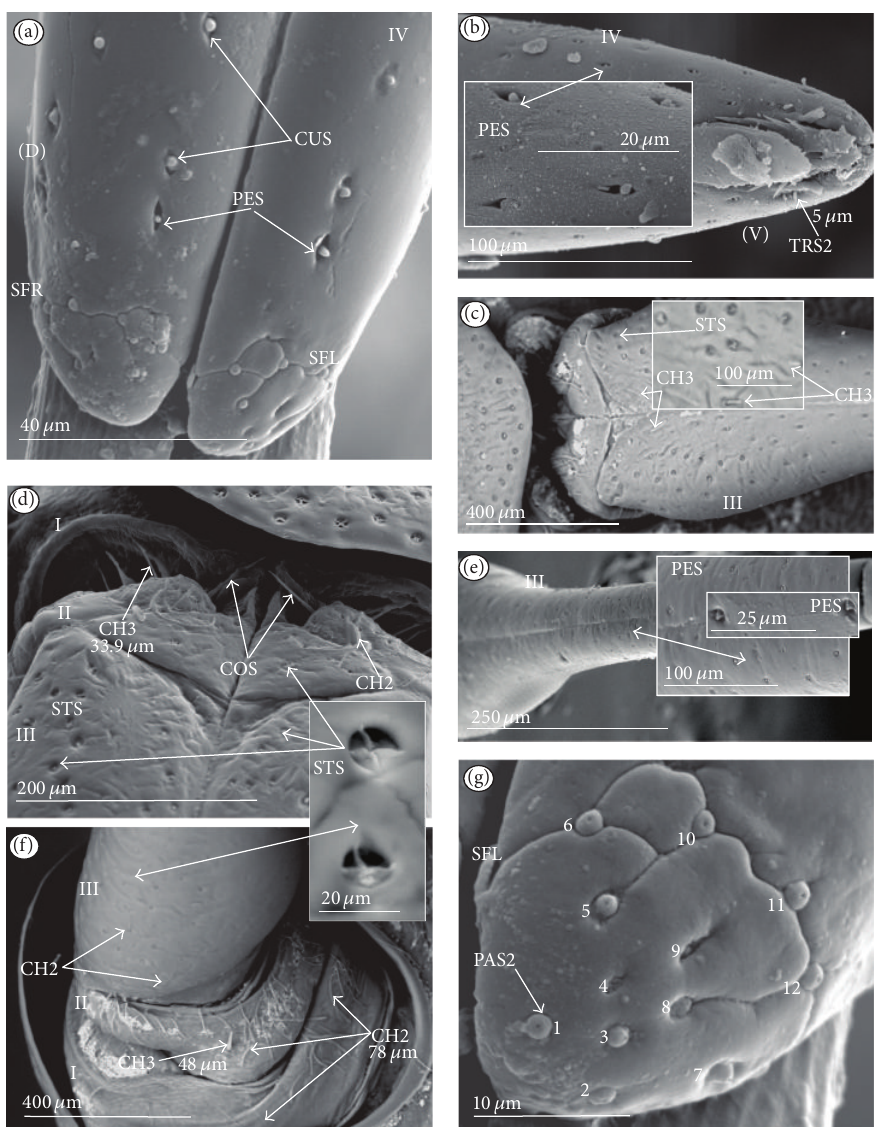
Figure 18: Types and sizes of the sensilla of the Aphelocheiridae ( Aphelocheirus aestivalis ). (a) PES and CUS are numerous and distributed unevenly in rows on the IV segment (dorsal view). (b) TRS2 (one) is situated ventrally near the tip of the labium; PES and CUS are distributed similarly as on the dorsal side. (c) STA and CH3 are in the proximal part of the III segment (dorsal view). (d) STS, CH2, CH3, and COS are situated on the II segment (dorsal view). (e) PES are unevenly distributed on the dorsal surface of the distal part of segment III. (f) CH2 are not numerous and are situated ventrally (V) on segments I and II of the labium. (g) PAS2 (no. 1–12) are distributed over